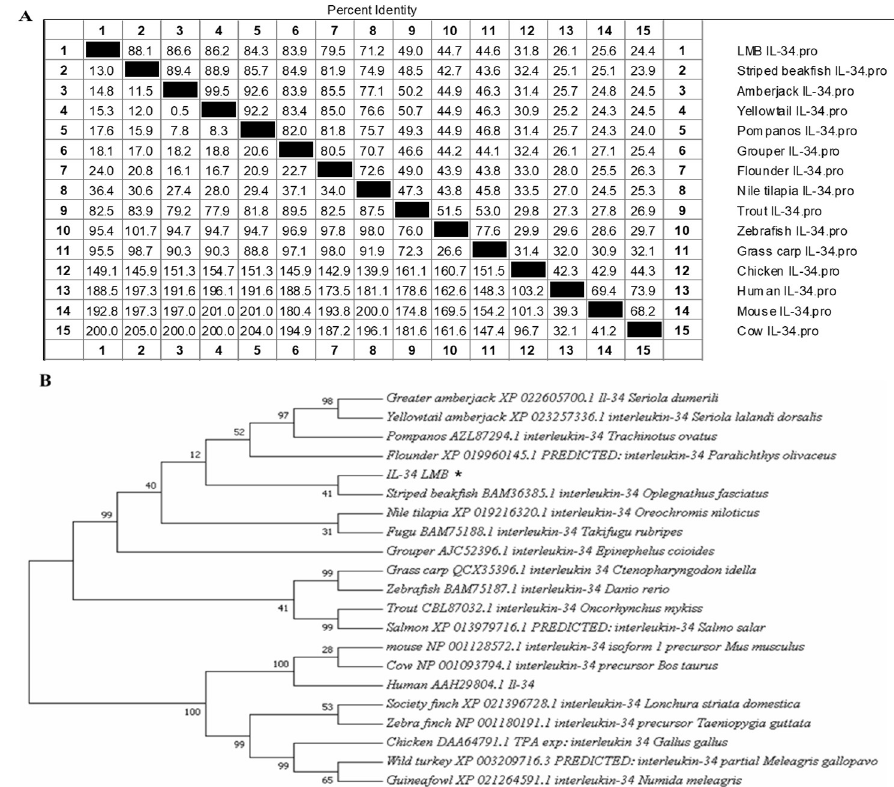
Figure 2. ( A ) Multiple sequences alignment of LMB-IL-34 with other reference IL-34s. ( B ) Phylogenetic tree of LMB-IL-34 with other reference IL-34s. The number at each branch represents the bootstrap values obtained with 1000 replicates. (*) indicates the LMB-IL-34 in this study.